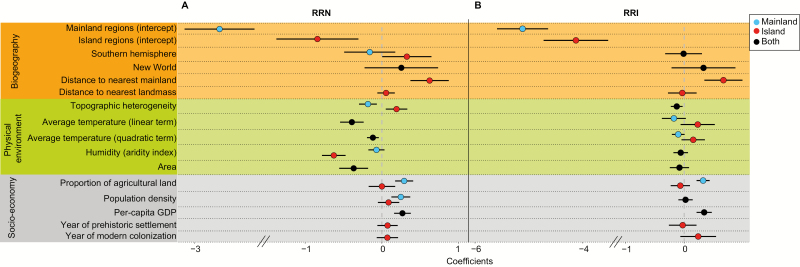
Regression coefficients of the 14 predictor variables that explain the relative richness of naturalized (RRN) (A) and invasive (RRI) (B) plants relative to native plants of 761 and 359 regions worldwide, respectively. Data on human colonization were only available for islands. The coefficients were estimated by GLMMs, and the lines show their 95 % confidence intervals. Separate coefficients for mainland vs. island regions were used only if this separation yielded a lower AIC value than a single coefficient for both region kinds. Numerical predictor variables were standardized. The full models are provided in Table 1.